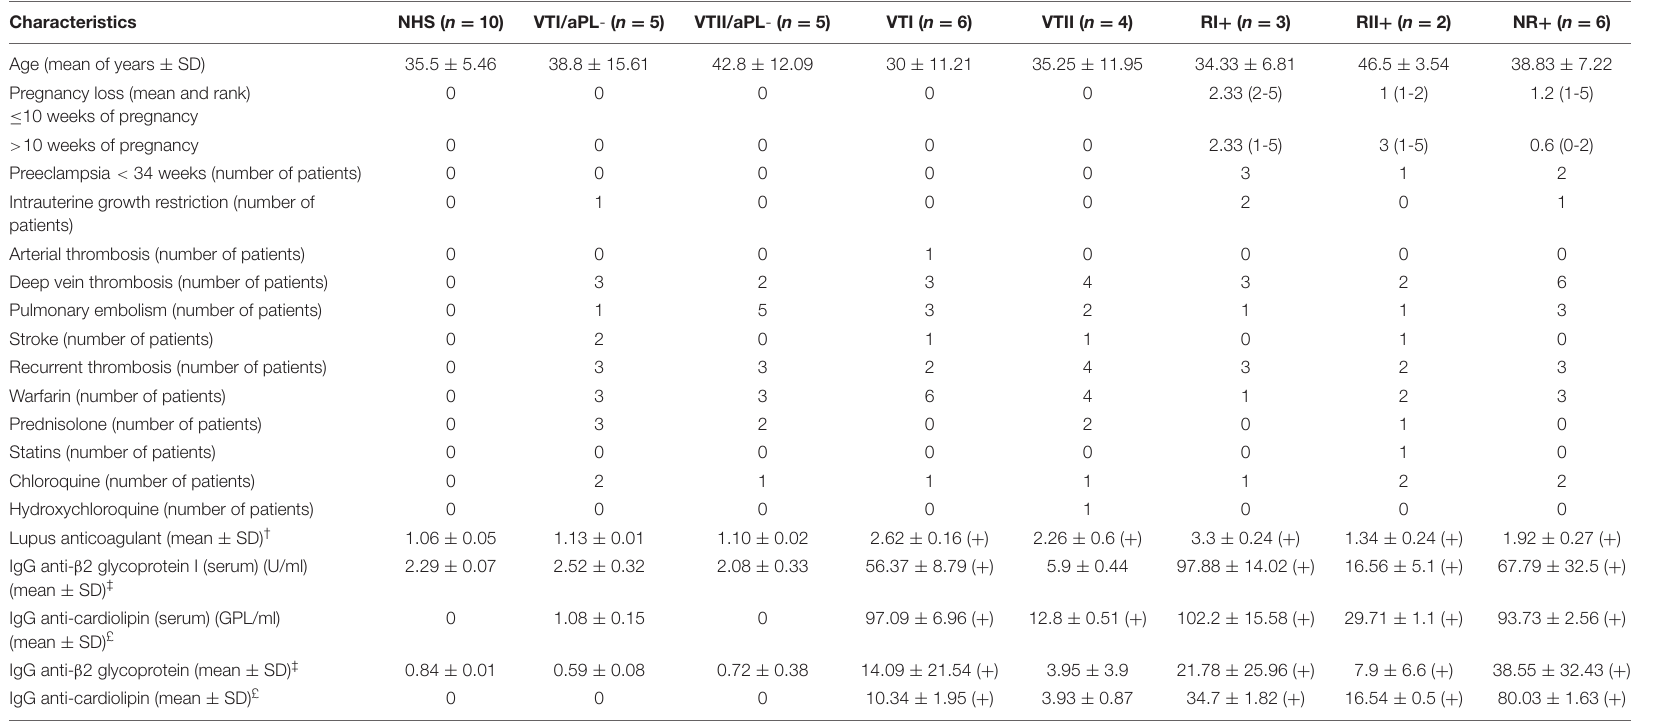
TABLE 1 | Characteristics of patients included in this study.